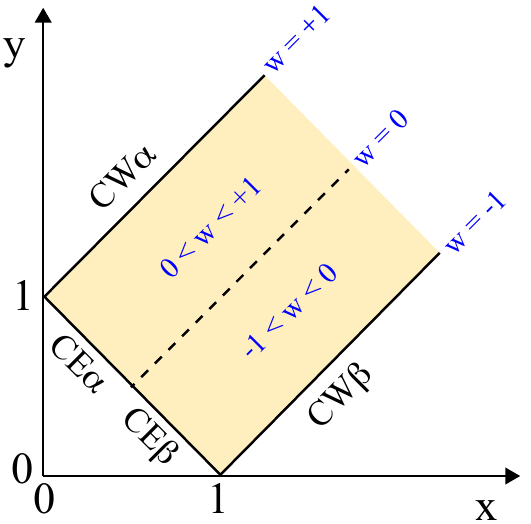
Figure 11. Force balance regime (yellow) and rescaled affinity contrast w as a tension ratios x = Σ m αγ / Σ αβ and y = Σ m / Σ αβ , corresponding to the membrane segment tensions Σ m αγ and Σ m βγ βγ divided by the interfacial tension Σ αβ . The rescaled affinity contrast w is defined in Equation (18). Within the yellow regime, the three surface tensions can balance each other along the contact line of droplet and vesicle. The force balance regime is bounded from below by the CW β line of complete wetting of the vesicle membrane by the β phase with w = − 1 and from above by the CW α line of complete wetting by the α phase with w = + 1. The left boundary with y = 1 − x corresponds to complete engulfment of an α droplet (CE α ) and to complete engulfment of a β droplet (CE β ), depend- ing on the sign of the affinity contrast w . Balanced adhesion with w = 0 (dashed line) divides the force balance regime up into a partial wetting regime by the β phase with − 1 < w < 0 and a partial wetting regime by the α phase with 0 < w < + 1. The corner point with x = 1 and y = 0 corresponds to the limit of small segment tensions Σ m , the corner point with x = 0 and y = 1 to the limit of small βγ Σ m αγ . Below the CW β line, the vesicle avoids any contact with the α phase as in Figure 2e; above the CW α line, the vesicle has no contact with the β phase as in Figure